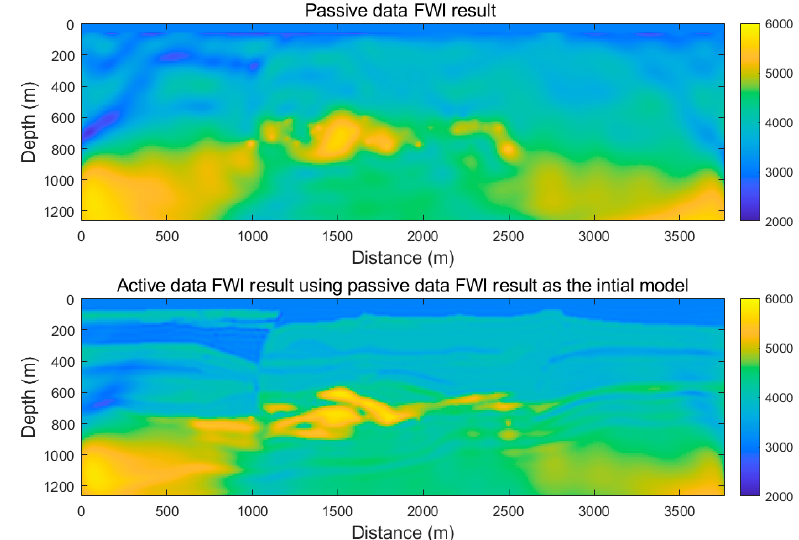
Figure 8. The source independent multisource FWI results. The upper figure is the passive source FWI results and the lower figure is the active source FWI result using the passive source FWI result as the initial model.